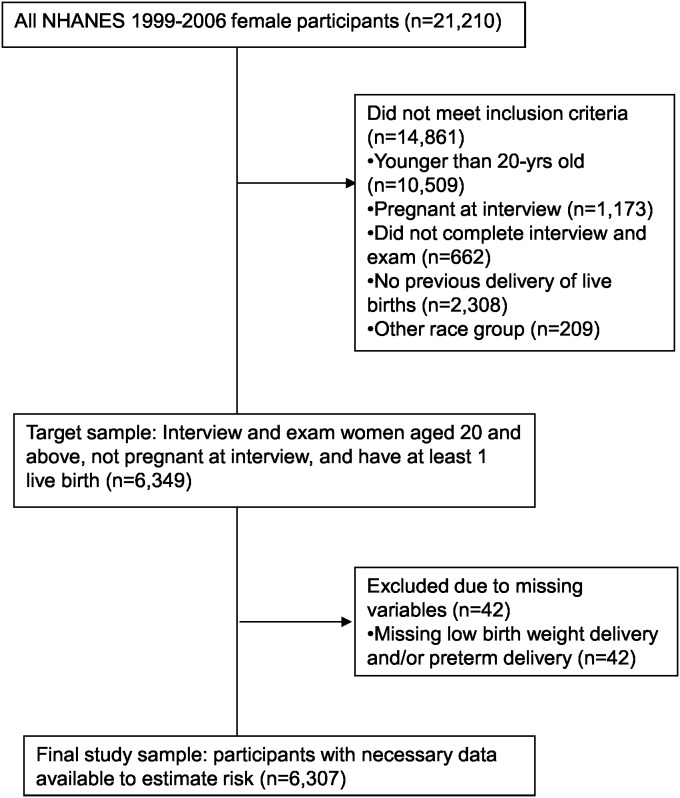
Participant flowchart.From the population of 21,210 female participants in the NHANES 1999–2006, women who were younger than 20-year old (n = 10,509), pregnant at the interview (n = 1,173), did not complete interview and exam (n = 662), did not report previous live birth delivery (n = 2,308), or were in other race group (n = 209) were excluded. This led to a target population of 6,349 women. Women who did not answer the pregnancy history questions were excluded from the target population (n = 42). Therefore, a total of 6,307 women were included in the analysis.